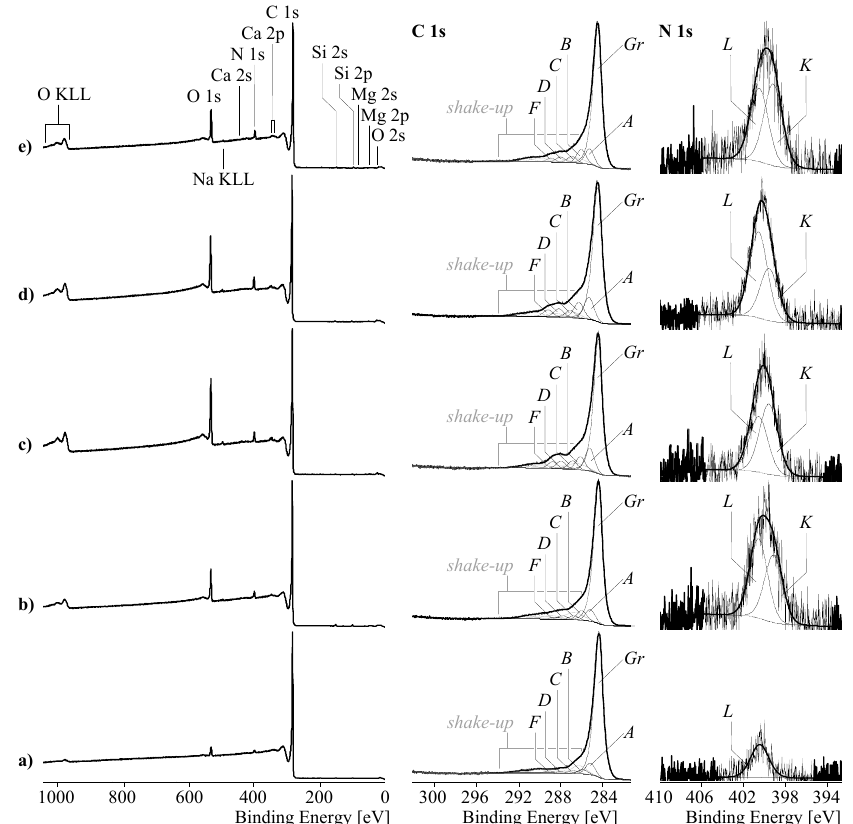
Figure 3. Wide-scan photoelectron spectra (left column), C 1s (middle column) and N 1s high-resolution photoelectron spectra (right column) recorded from unmodified carbon fibres (sample 1) ( a ), and electro-chemically modified carbon fibres at low current and low current and low conductivity (sample 2) ( b ), high current and low conductivity (sample 4) ( c ), high current and high conductivity (sample 5) ( d ), and low current and high conductivity (sample 7) ( e ). Table 5. Fractions of component peak areas.